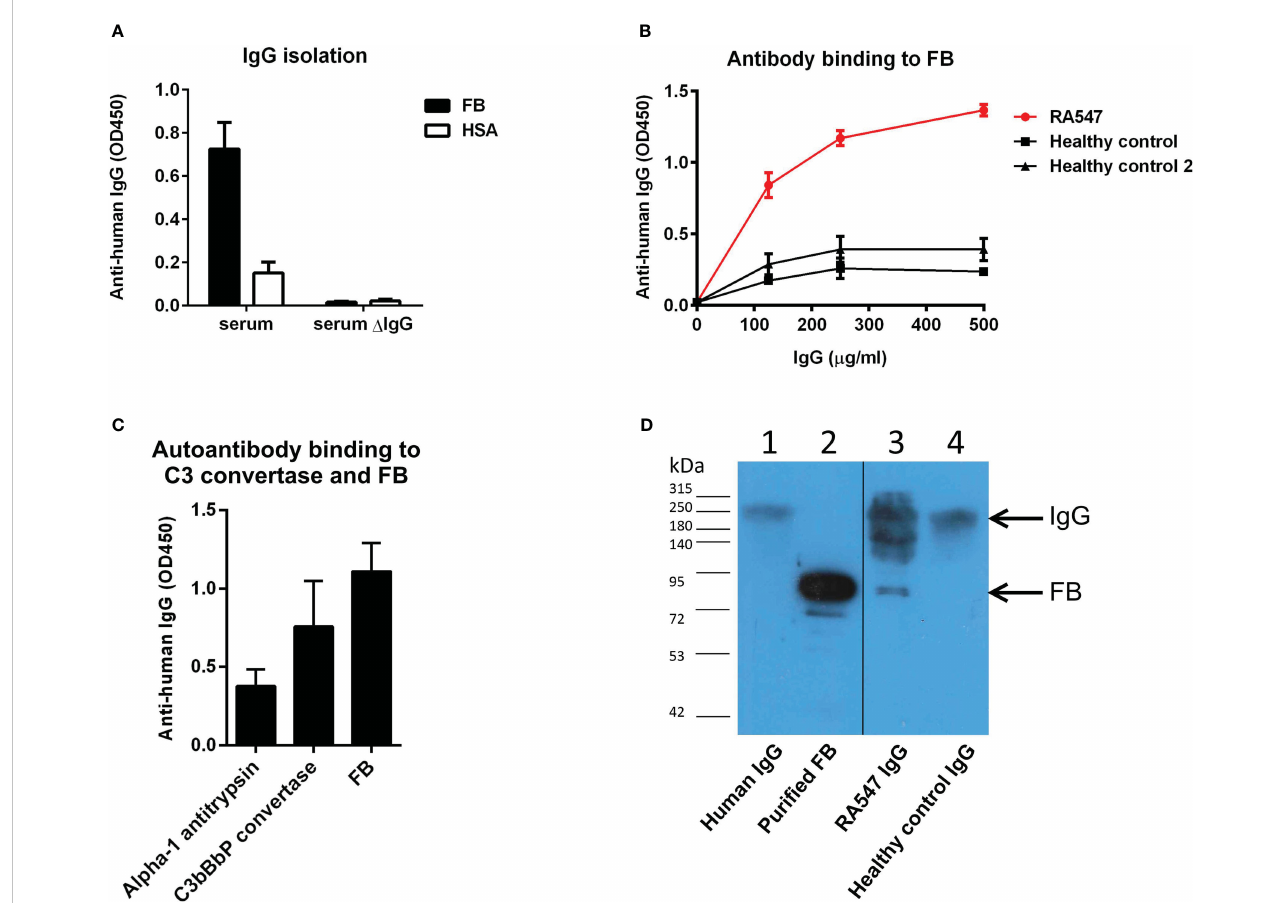
FIGURE 3 Anti-FB autoantibody characterization. (A) IgG was isolated with Protein G column from RA547 patient ’ s serum and healthy controls ’ sera. The IgG depleted serum lost its ability to bind FB. (B) Serial dilutions from RA patient ’ s IgG showed dose-dependent binding to FB in contrast to healthy control IgG. Data are mean ± SD from three independent experiments. (C) Autoanti-FB bound to FB as part of the C3 convertase of the alternative pathway (C3bBbP). (D) In vivo formed IgG-FB complexes were detected in the patient ’ s IgG fraction with polyclonal anti-FB antibody in Western blot. Lanes: 1: puri fi ed IgG, 2: puri fi ed FB, 3: RA547 IgG, 4: Healthy control IgG. 25 µg isolated IgG was run on SDS-PAGE, blotted onto nitrocellulose membrane, and developed by anti-FB antibody. Blot is representative of three